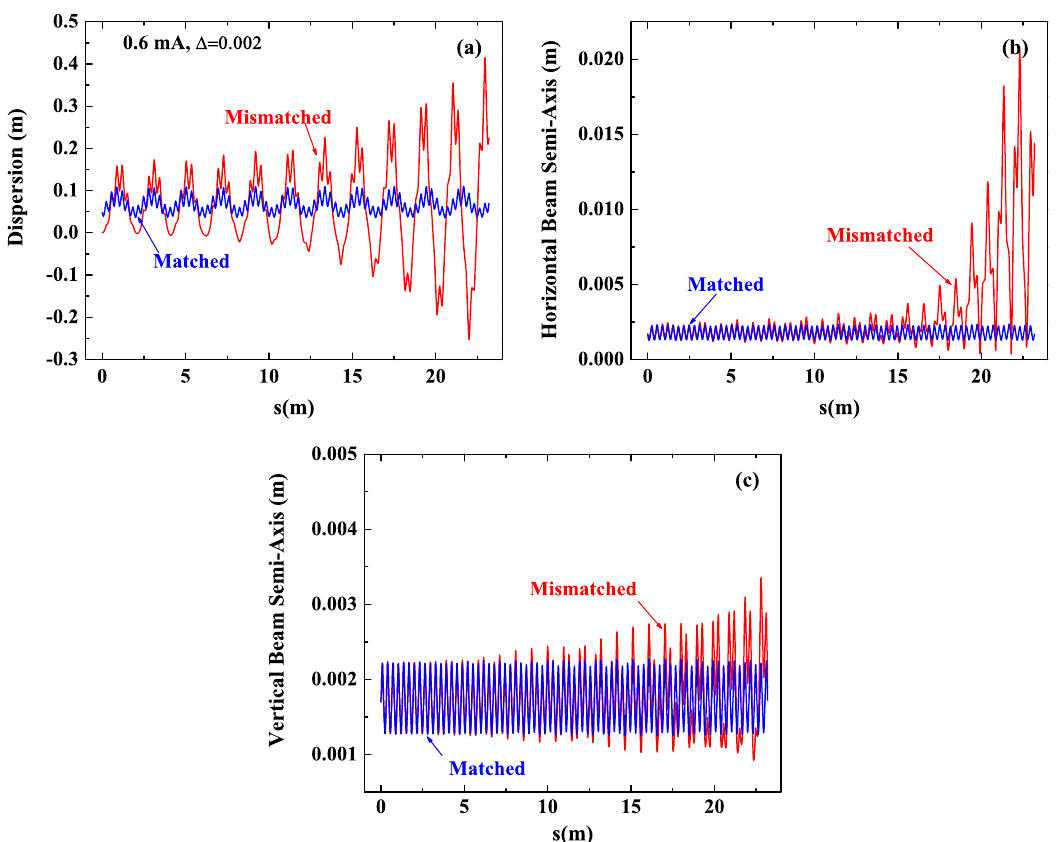
FIG. 2. Dispersion and beam envelopes over two turns in UMER from solutions of the V-R equations; matched and mismatched cases for 0.6 mA, (cid:1) ¼ 0 : 002 are shown: (a) dispersion functions, (b) horizontal beam envelopes, and (c) vertical beam